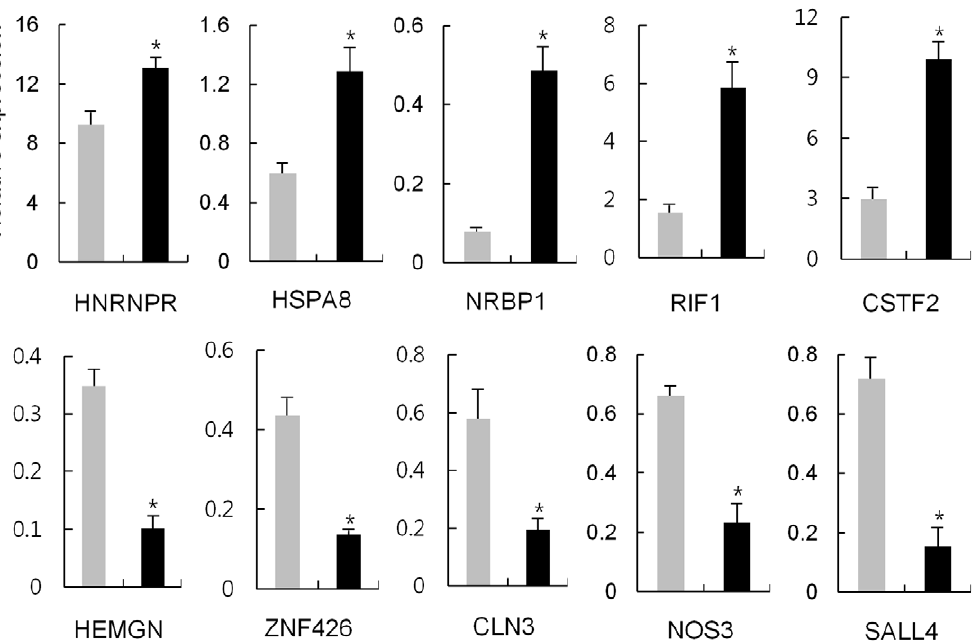
Figure 7. RT-PCR analysis of selected genes induced by D LF. Gray and black bars denote the expression of the indicated genes for non- treated and treated with tetracycline in the D LF cells, respectively. Each sample was analyzed in duplicate, and the average relative expression level of 15 clones is presented. *Significant (P , 0.05; Student’s t -test).